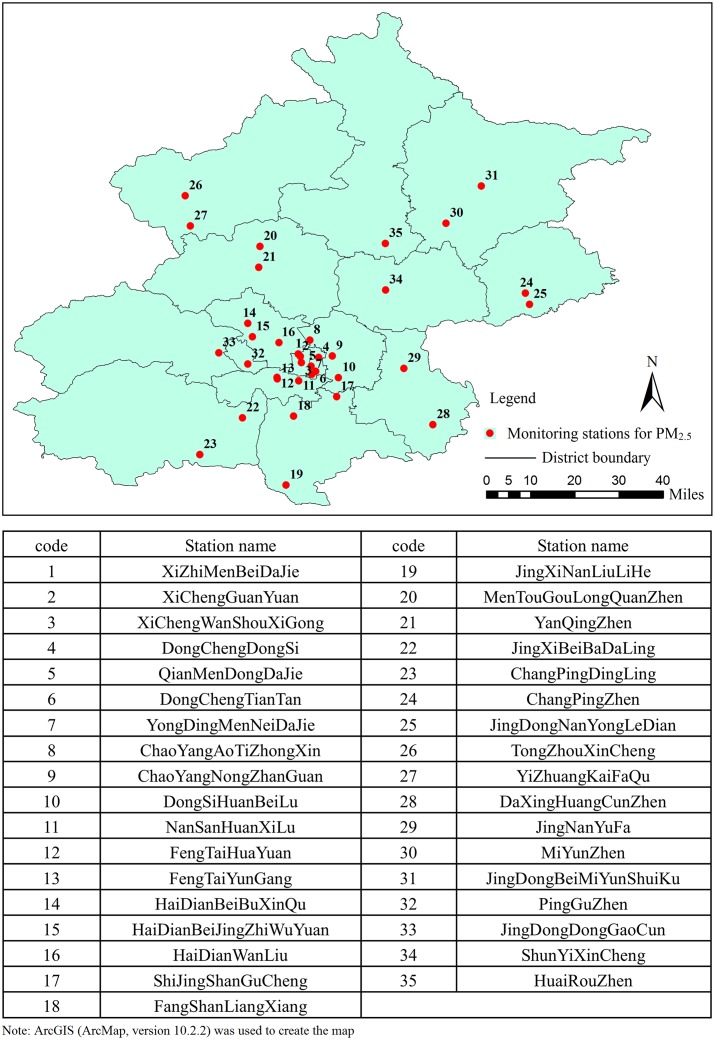
Locations of the 35 PM2.5 monitoring stations in Beijing.